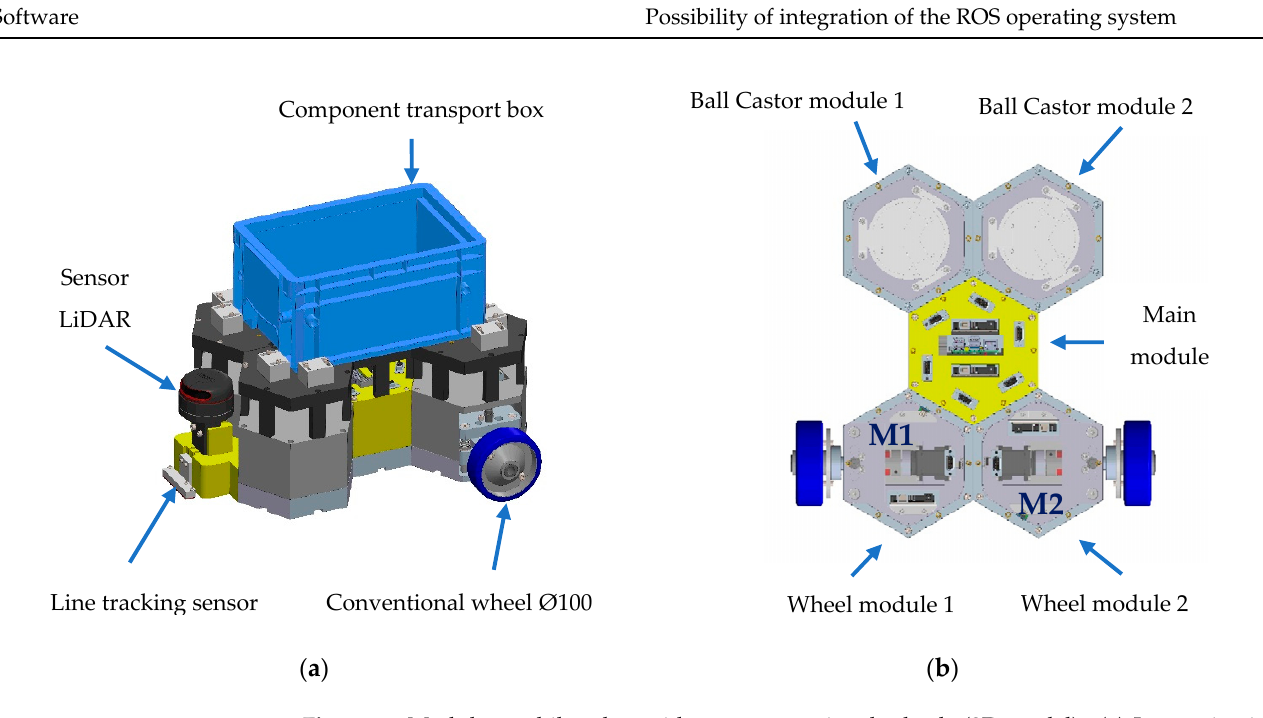
Figure 3. Modular mobile robot with two conventional wheels (3D model). ( a ) Isometric view. ( b ) Top view.